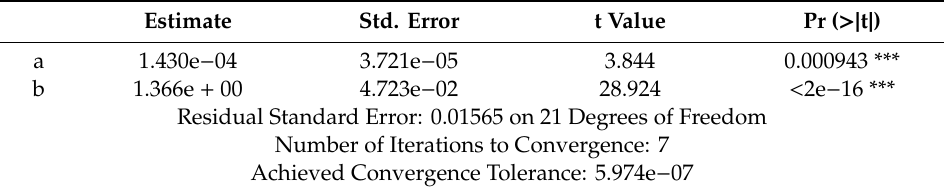
Table 10. Statistical parameters for the nonlinear regression model.